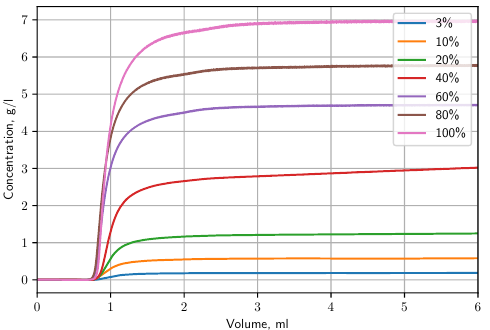
Figure 4. Breakthrough curves of butyl-benzoate samples at different concentration levels.